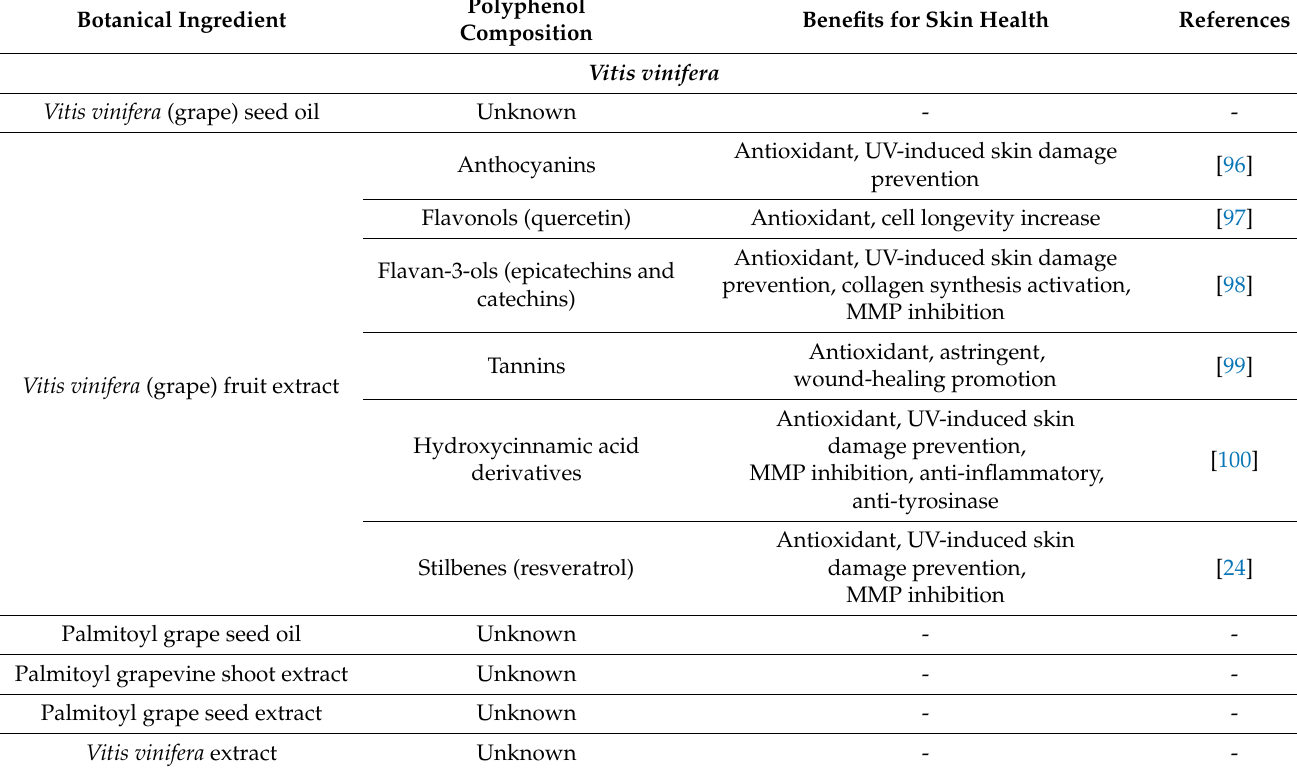
Table 3. Polyphenol composition of the top 10 botanical preparations, and their benefits for skin health. Botanical